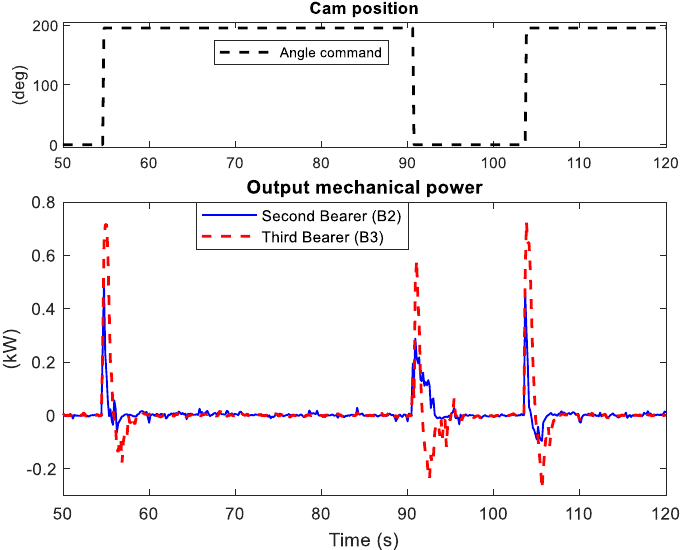
Figure 16. Mechanical power of the two bearers B2 and B3 at double actuation mode.